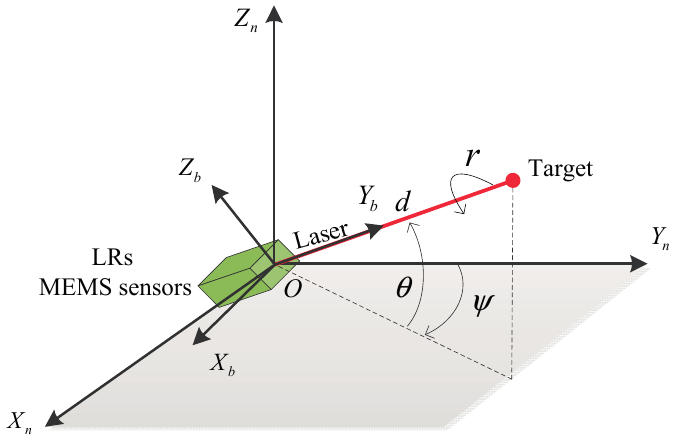
Figure 2. Target positioning using the proposed